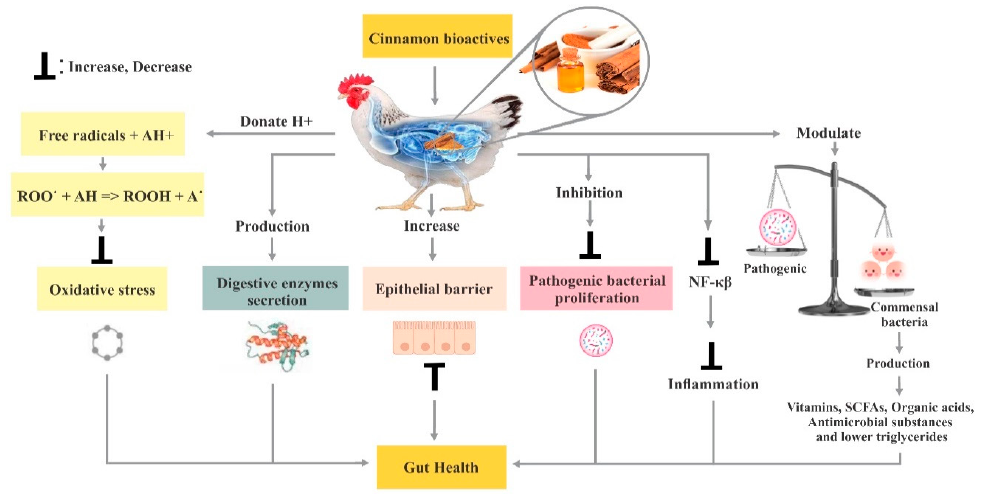
Figure 1. Effect of cinnamon on poultry gut health.